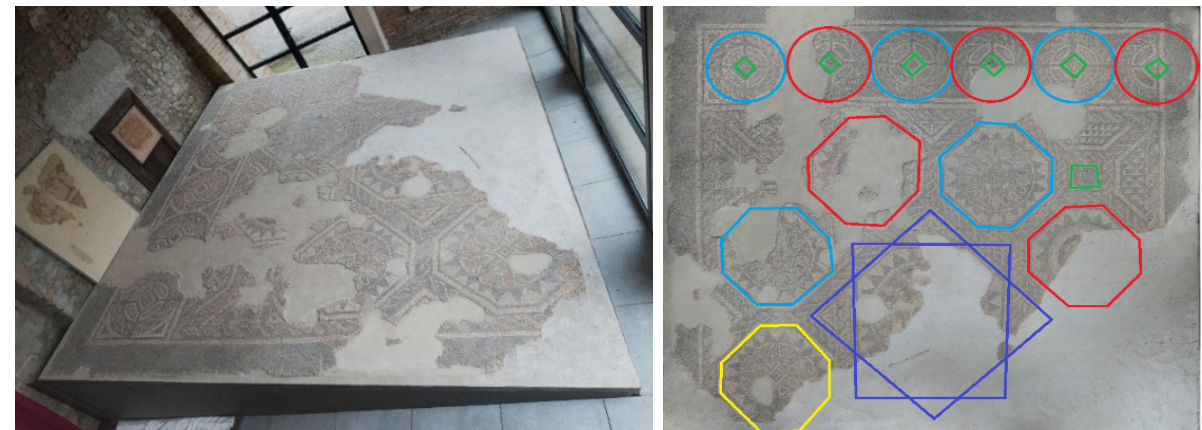
Figure 3. Left : The final location at the “Casa Natale Giuseppe Graziosi” in Savignano sul Panaro (Modena, Italy) (photo credits: Marianna Grandi, Italy). Right : Auxiliary geometric elements built on the orthophoto of the Roman mosaic, to highlight the geometric forms and their arrangement.